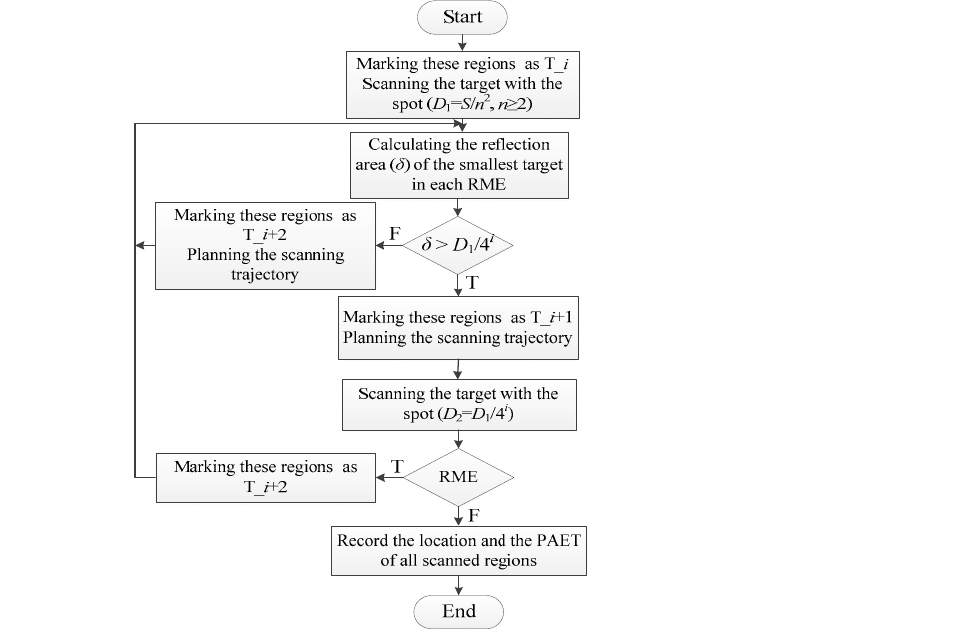
Figure 2. The scanning strategy with the variable scanning spot and scanning trajectory. Step 1. Rough scanning. For the target with the area of S , set the scanning step of this region, i.e., T_ i , where T is the flag of scanning order, and i is the i -th scanning step. Using the scanning spot with the area of D 1 = S / n 2 ( n is the number of the sub-region of the target, n ≥ 2) to scan the target, shown in Figure 3a. Then the waveform processing and pulse extraction are carried out on the echo signal of each region received by the detector [31].